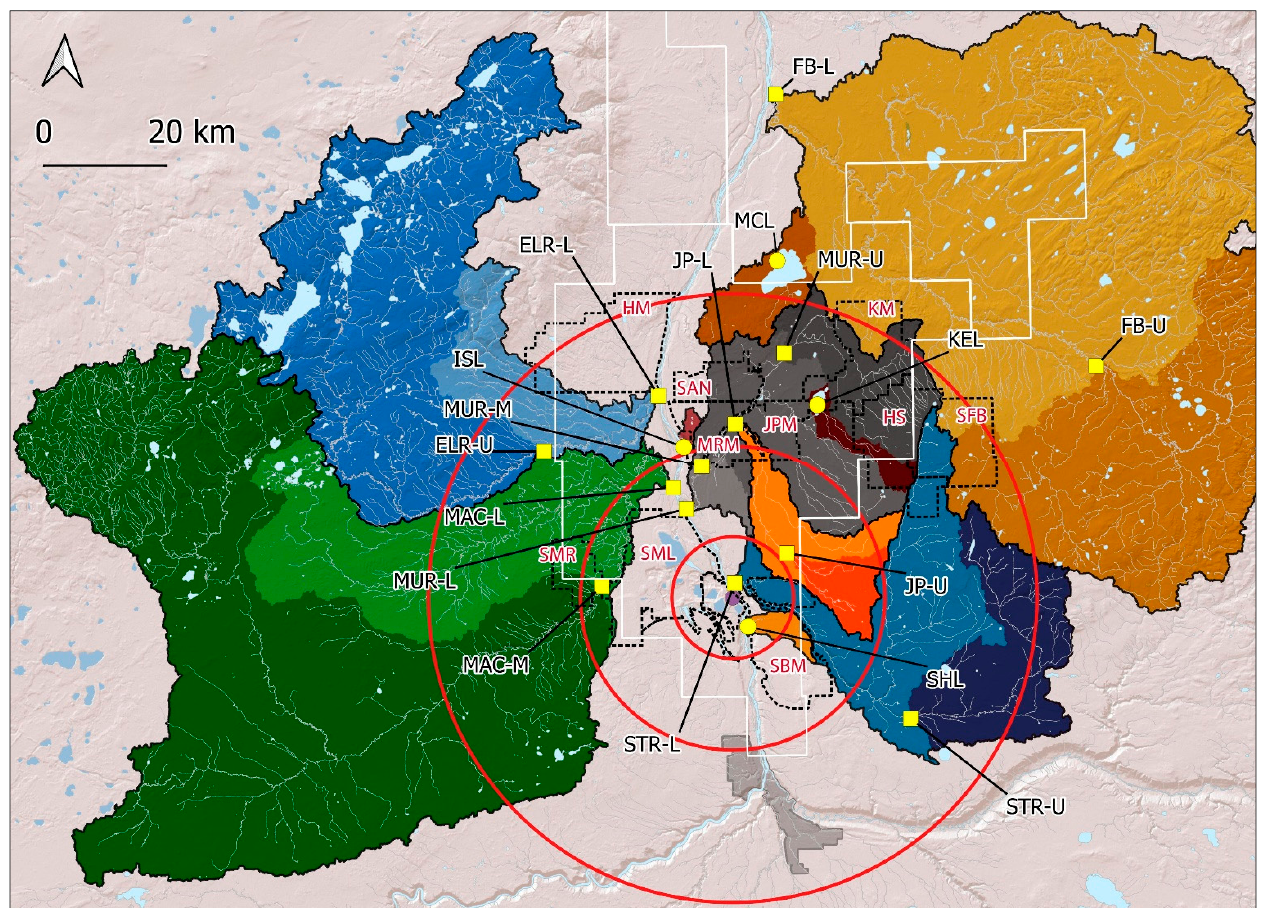
Figure 1. Map of study area showing stream sites (yellow squares), lake sites (yellow circles), boundaries of projects active in 2015 (dashed polygons; facility acronyms in red text) and areas upslope of each study location (colored areas) in the minable region (solid white line); also shown is location of Suncor’s main upgrading complex (purple circle) and concentric rings 10, 25, and 50 km from this location (in red); waterbodies: STR = Steepbank River; JP = Jackpine Creek; MUR = Muskeg River; FB = Firebag River; ELR = Ells River; MAC = MacKay River; SHP = Shipyard Lake; ISL = Isadore’s Lake; MCL = McClelland Lake; site location designation: L = Lower; U = Upper; M = Middle; Industrial project boundaries: HM = Horizon Mine; SAN = Syncrude Aurora North; MRM = Muskeg River Mine; JPM = Jackpine Mine; KM = Kearl Mine; HS = Husky Sunrise; SFB = Suncor Firebag; SBM = Suncor Basemine; SML = Syncrude Mildred Lake; SMR = Suncor MacKay River.